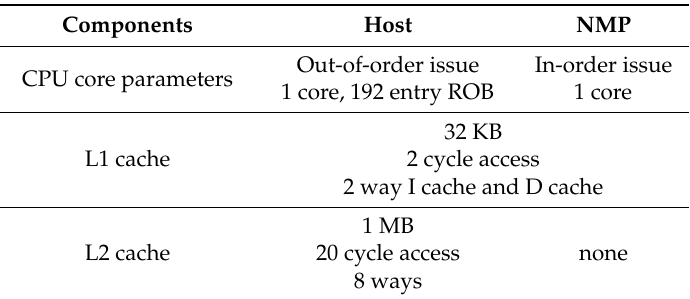
Table 1. Host and NMP